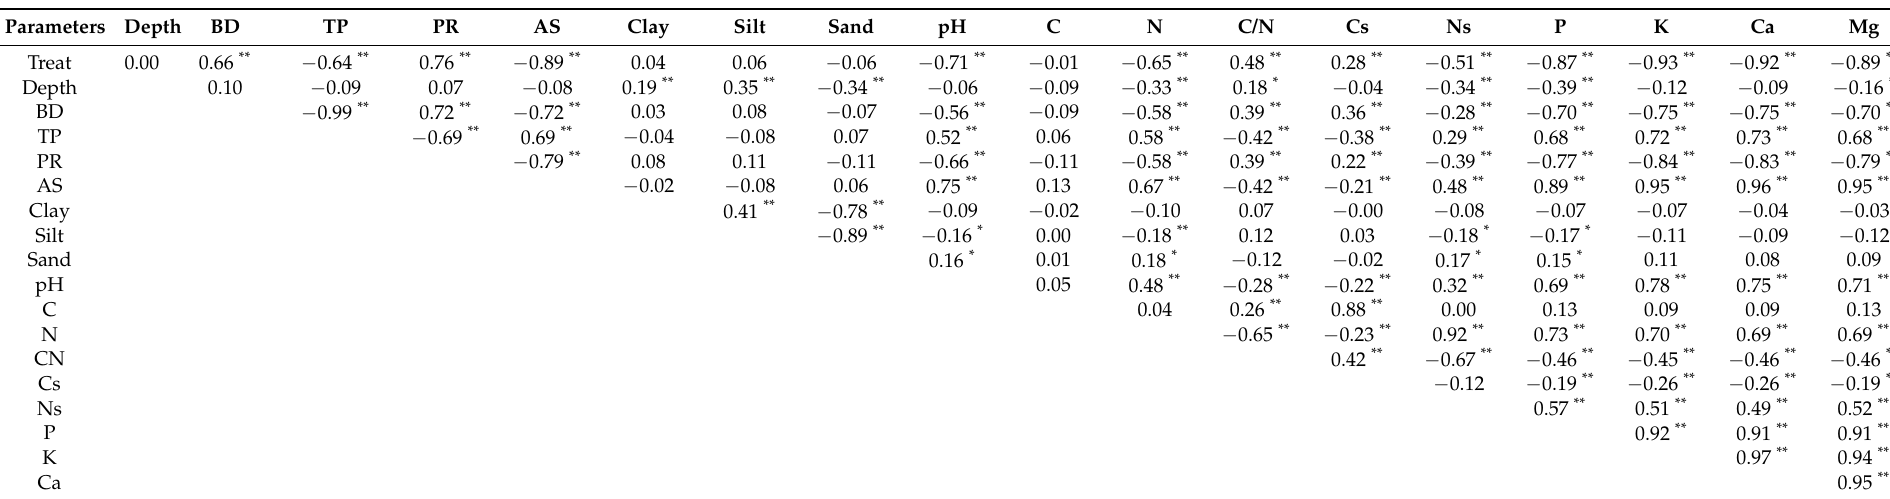
Table 4. Pearson correlation coefficient ( r value) between soil physical and chemical properties. BD = Bulk density (g cm − 3 ), TP = Total porosity (%), PR = Penetration resistance (MPa), AS = Aggregate stability (%), Clay (%), Silt (%), Sand (%), pH = pH (1:2.5 H 2 O), C = C (%), N = N (%), C/N = C/N Soil, Cs = C storage (Mg ha − 1 ), Ns = N storage (Mg ha − 1 ), P = P (mg kg − 1